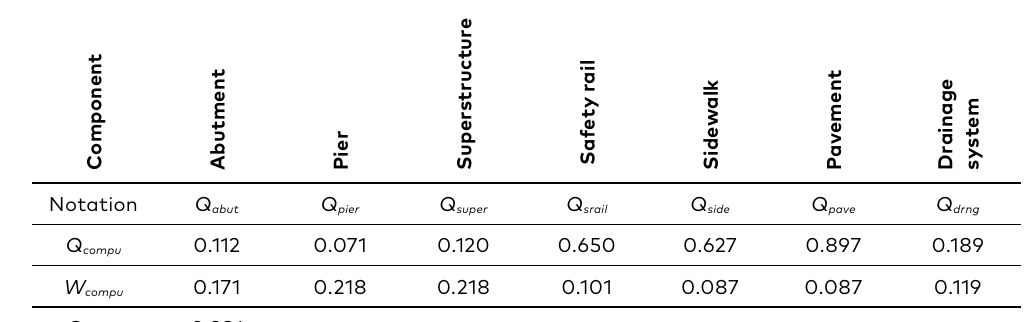
Table 4. Quality performance of the components and system of the Strimonas Bridge